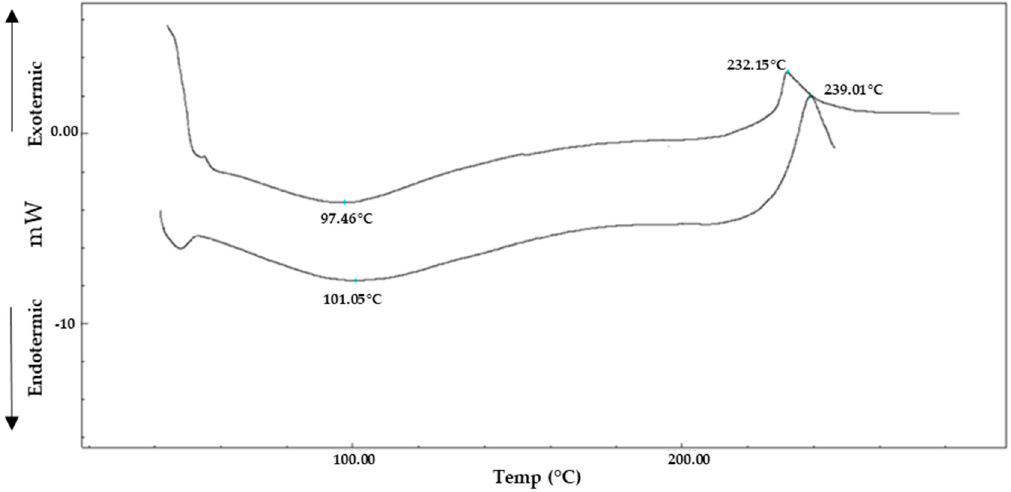
Figure 4. DSC thermograms of native HA and HA–Orn.